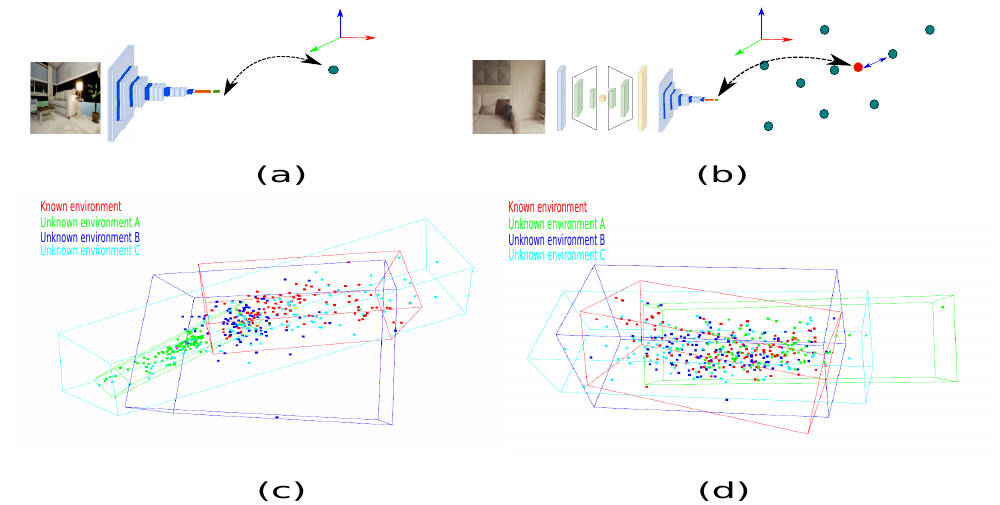
Figure 6. Samples plotted in a 3D space. ( a ) A DCNN plots a sample in 3D space. ( b ) Implementation of the transfer style approach. ( c ) Three-dimensional description of the distribution of samples between different domains. ( d ) Graphical description of the samples with transfer style. Table 2. Features description for each unknown